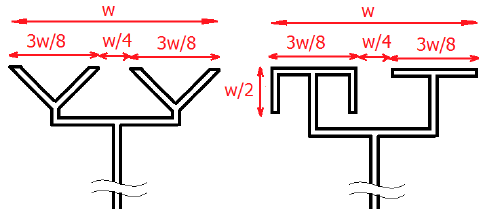
Figure 6. Examples of double-cap barriers of all possible existing combinations. The total envelope size is maintained.